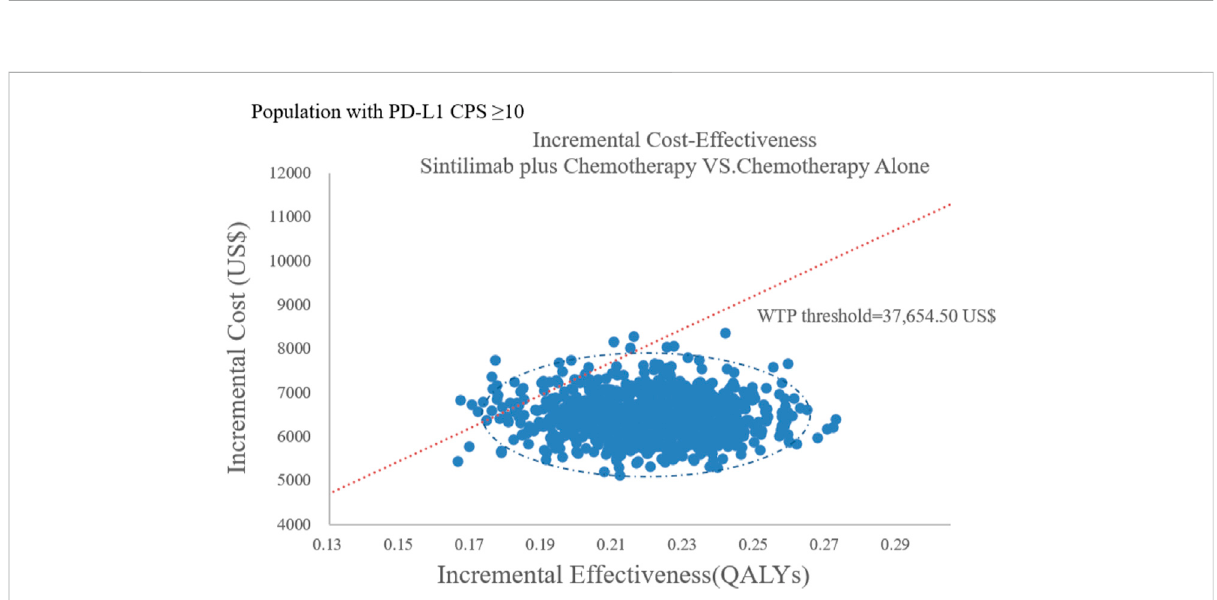
FIGURE 7 Probabilistic sensitivityanalysesinthesubgroup.Note:thedotrepresentstheresultoftheMonteCarlosimulation.Thediagonallinerepresents the WTP value, and the dot falls below the diagonal line to indicate that the test group has a cost effect compared with the control